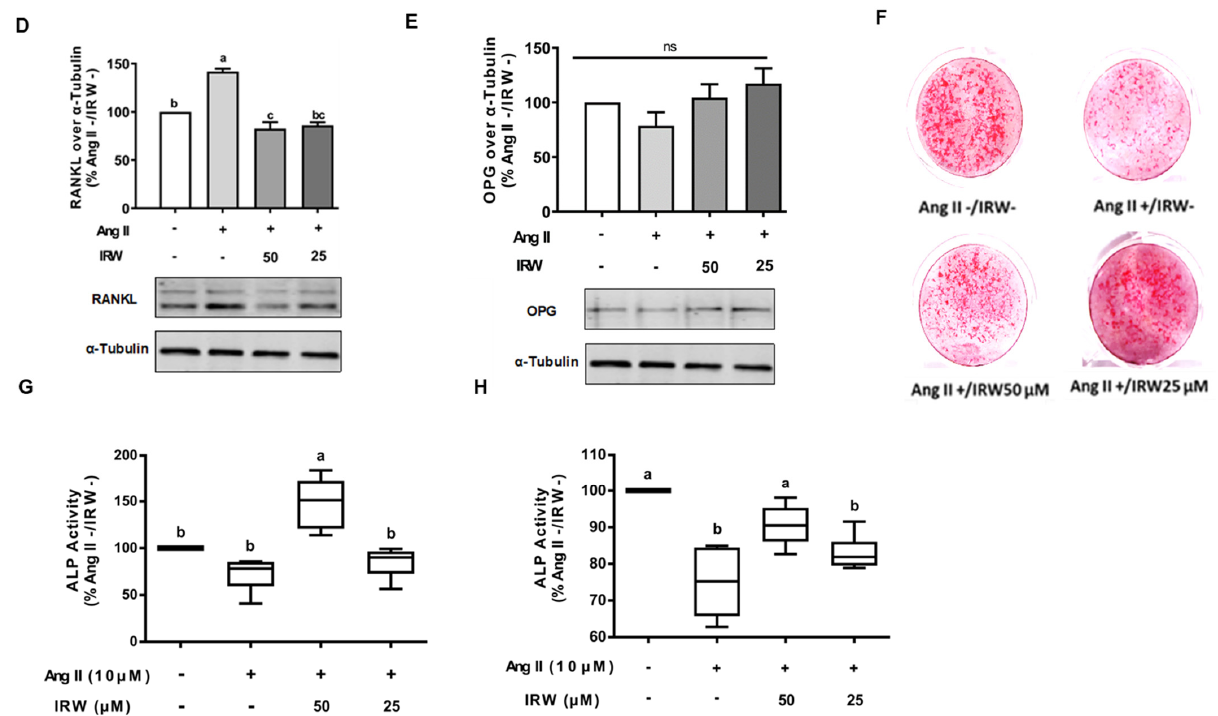
Figure 1. The effect of IRW on promoting osteoblastic activity against Ang II stimulation. ( A ) Oste- oblast cells MC3T3-E1 were pre-treated with IRW (50 μ M and 25 μ M) for 2 h prior to Ang II (1 μ M) and then co-cultured for 24 h. BrDU incorporation assay ( A ) was performed as described in meth- odology and the BrDU positive cells were counted; ( B – H ) osteoblast cells MC3T3-E1 were pre- treated with IRW (50 μ M and 25 μ M) for 2 h prior to Ang II (1 μ M) and then co-cultured for 24 h. Whole cell lysates were used for the Western blotting analysis of COL1A2 ( B ), ALP ( C ), RANKL ( D ), and OPG ( E ). ( F ) Osteoblast cells MC3T3-E1 were cultured in mineralization medium (MEM- α medium with ascorbic acid and β -glycerophosphate) and treated with IRW (50 μ M and 25 μ M) and Ang II (1 μ M) for 15 days. Alizarin Red staining was performed, and the images were captured. ( G,H ) Osteoblast cells MC3T3-E1 were pre-treated with IRW (50 μ M and 25 μ M) for 2 h prior to Ang II (1 μ M) and then co-cultured for 24 h. Both the culture medium ( G ) and whole cell lysates ( H ) were collected for ALP activity analysis. All results are representative of 4~6 independent experi- ments and expressed as mean ± SEM. Mean without a common letter indicated p < 0.05.